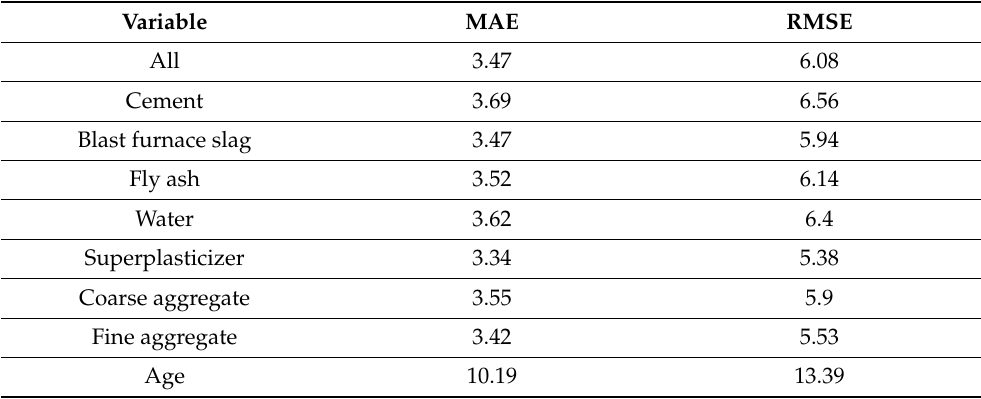
Table 4. Results of Sensitivity Analysis related to Kernel Regression model.